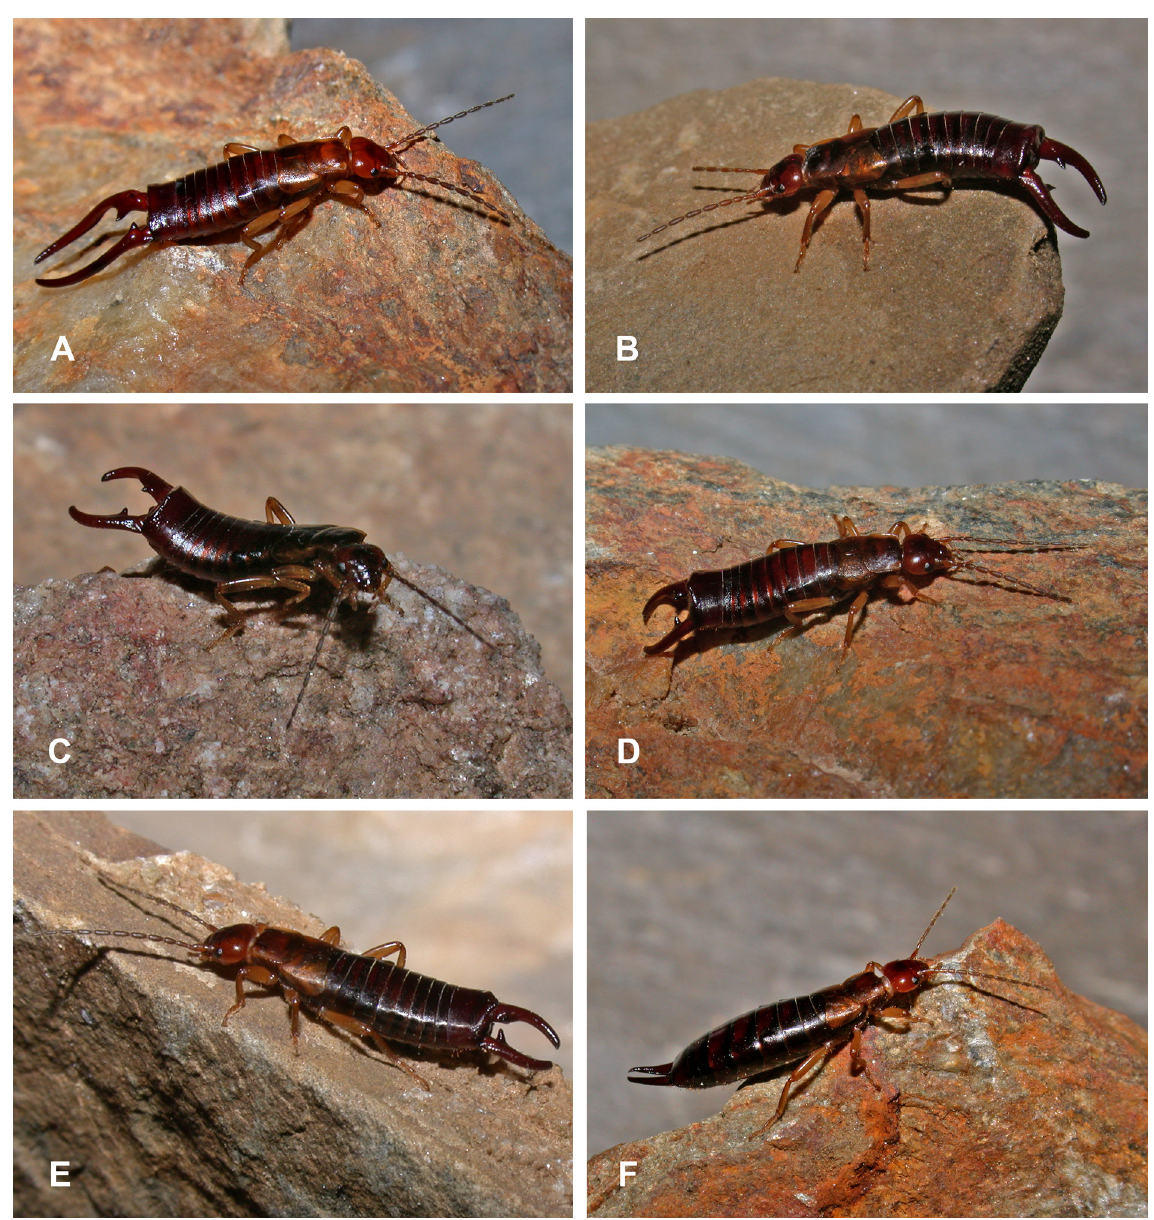
Fig. 9. Live specimens of Pseudochelidura sinuata (Germar, 1825) and cerci variation. A . Male from Ransol (Andorra). B . Male from Coll de Pailhères (Ariège, France). C . Male from Valle de Pineta (Huesca, Spain). D . Male from Ransol (Andorra). E . Male from Ransol (Andorra). F . Female from Ransol (Andorra). Photographs ex situ by